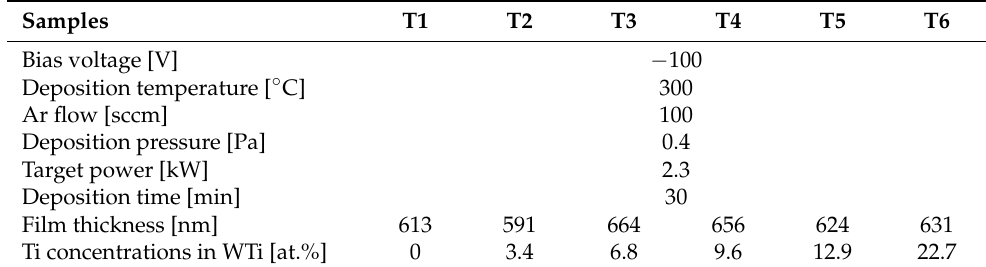
Table 2. Parameters of deposition for the W and WTi